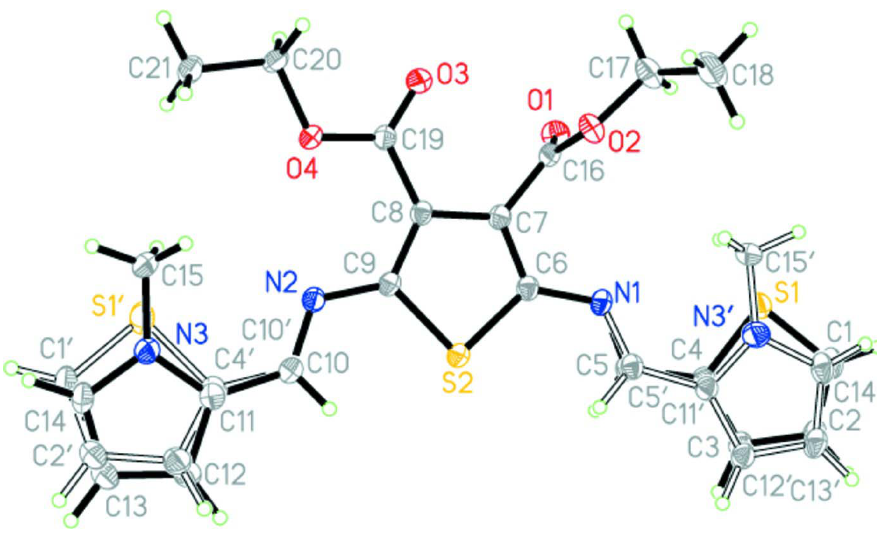
Figure 1 ORTEP representation of (I) showing the disorder present in the terminal rings with the numbering scheme adopted (Farrugia, 1997). Ellipsoids drawn at 30% probability